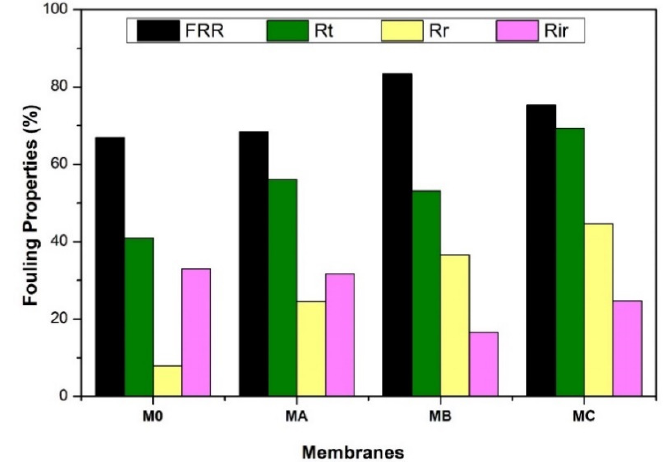
Figure 11. Antifouling performance of PES membranes without and with modification using dopamine at different concentrations.